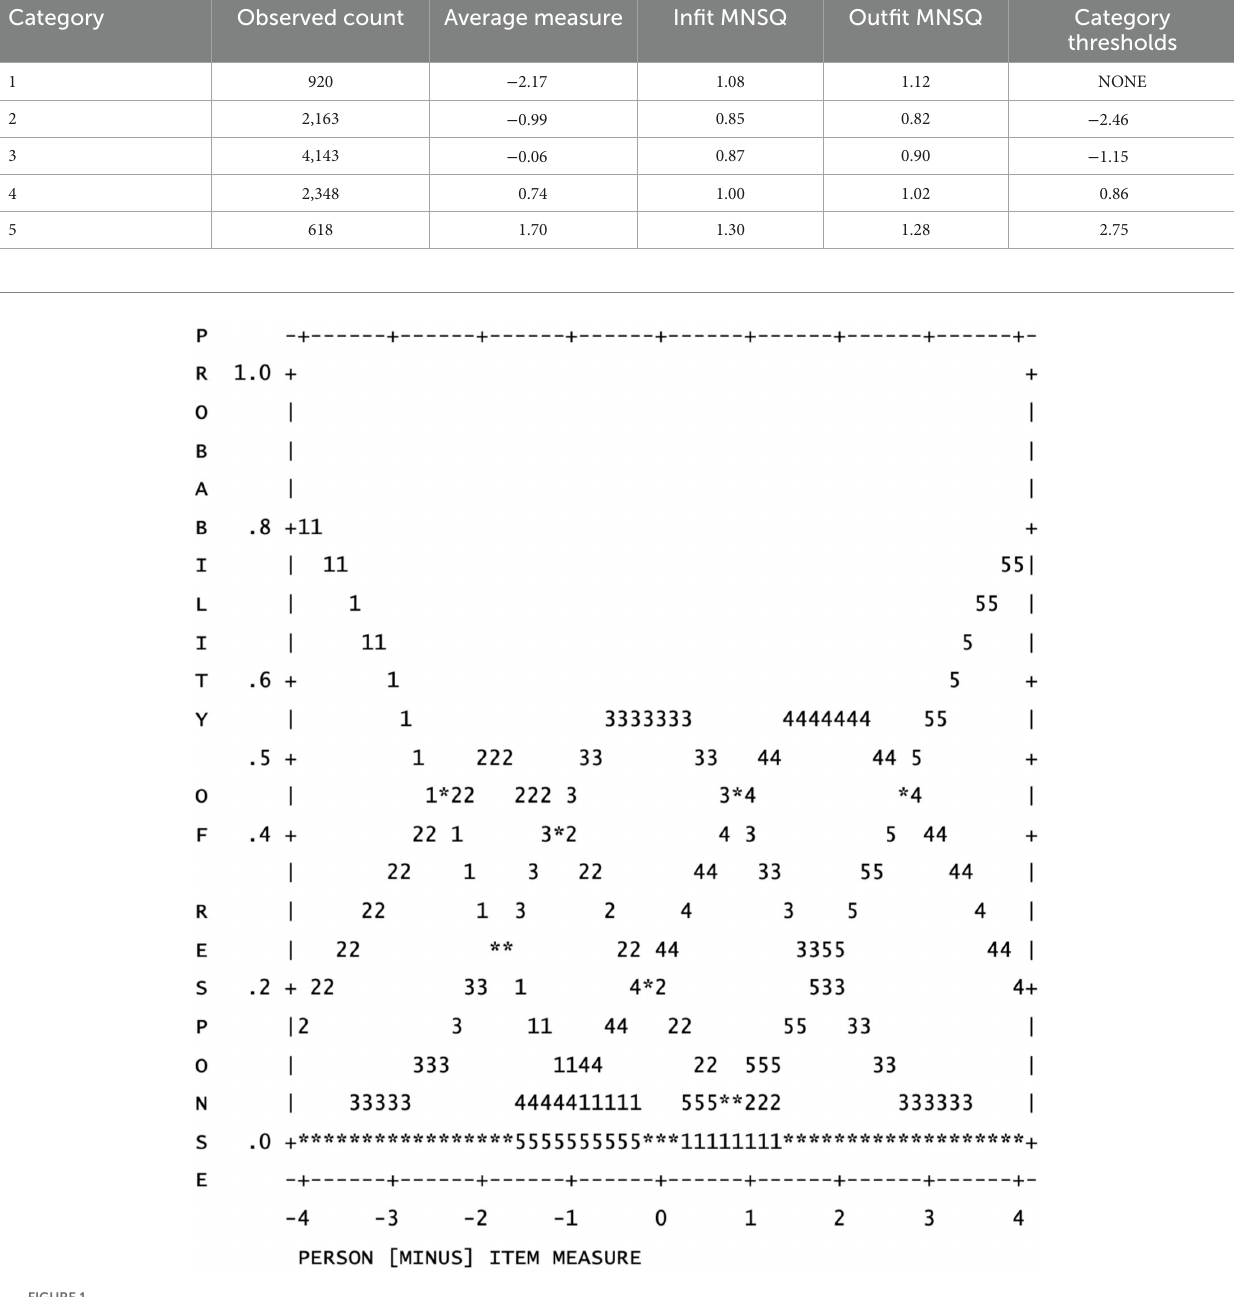
FIGURE 1 Category probabilities: Modes - structure measures at